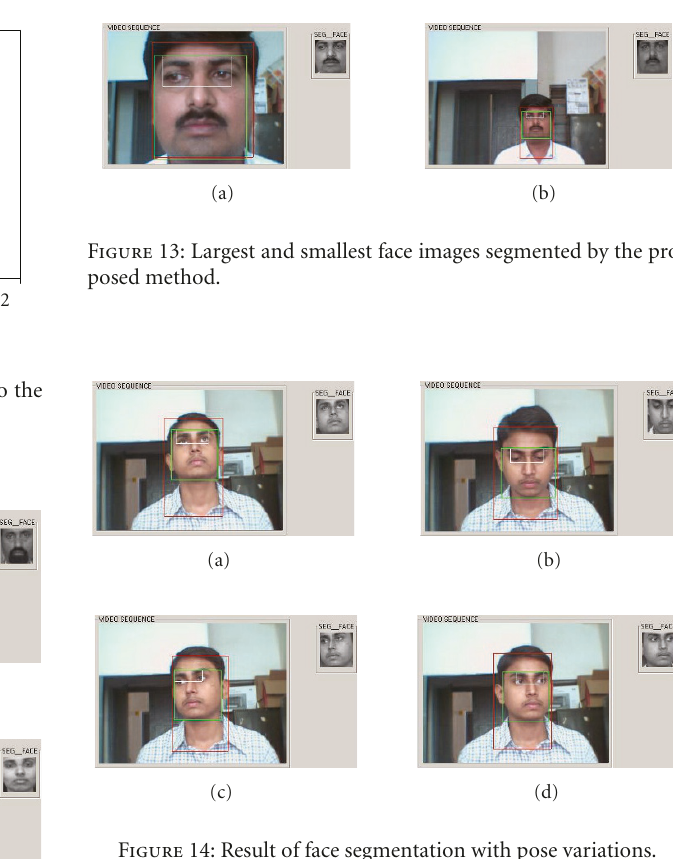
Figure 14: Result of face segmentation with pose variations.